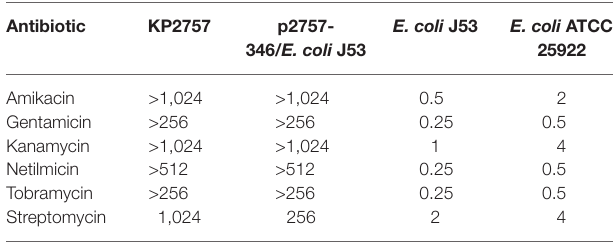
TABLE 2 | Antibiotic susceptibilities of KP2757, the transconjugant, the recipient control Escherichia coli J53, and the quality control strain E. coli ATCC 25922 (mg/L).